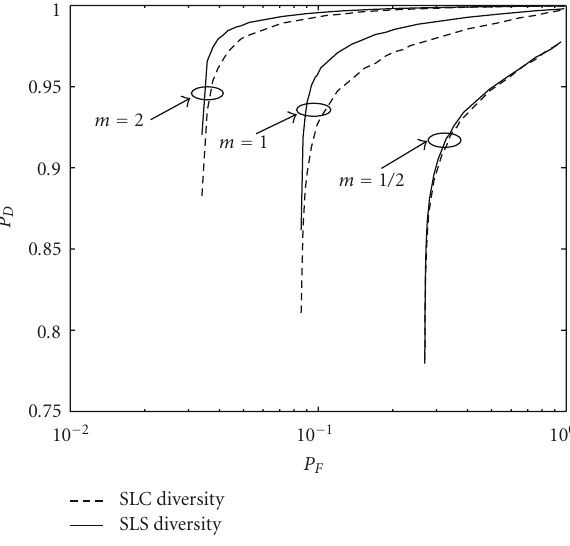
Figure 7: P D versus P F for K = 2 employing both Dual SLS and Dual SLC (i.i.d. diversity branches) for di ff erent Nakagami fading parameters, γ =